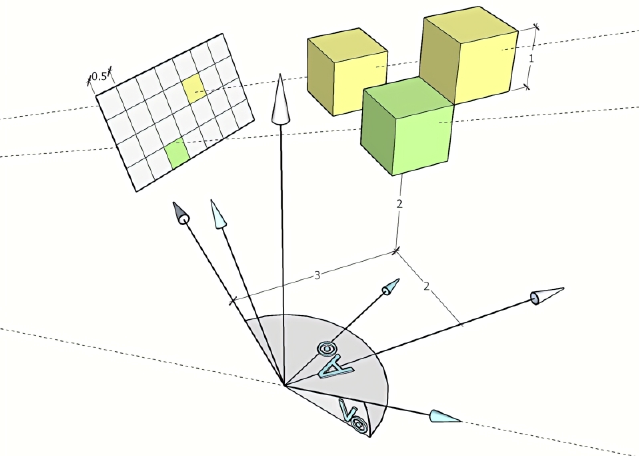
Figure 1. The illumination of the voxel grid at a given location and time is determined by the shadowing square grid with half the density compared to the voxel grid. The voxel grid coordinate system (white) rotated using the Sun’s azimuth A (cid:74) and altitude v (cid:74) into a Sun-oriented (turquoise) coordinate system. The example voxel coordinates (green voxel) and voxel size are